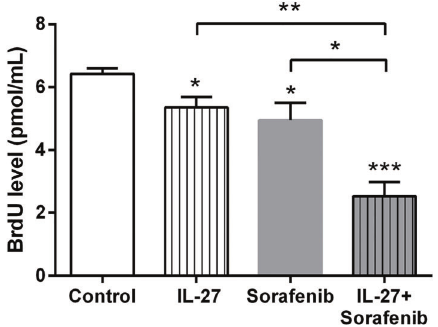
Figure 1. Effect of IL-27 (50 ng/mL) and sorafenib (2 m M) alone or their combination on cell proliferation of HTB-9 cells, performed by BrdU assay. Cells cultured with blank medium acted as control. Data are reported as the mean ± SE of 4 independent experi- ments. *P o 0.05; **P o 0.01; ***P o 0.001 compared to control unless indicated otherwise ( t -test). IL-27: interleukin 27; BrdU: